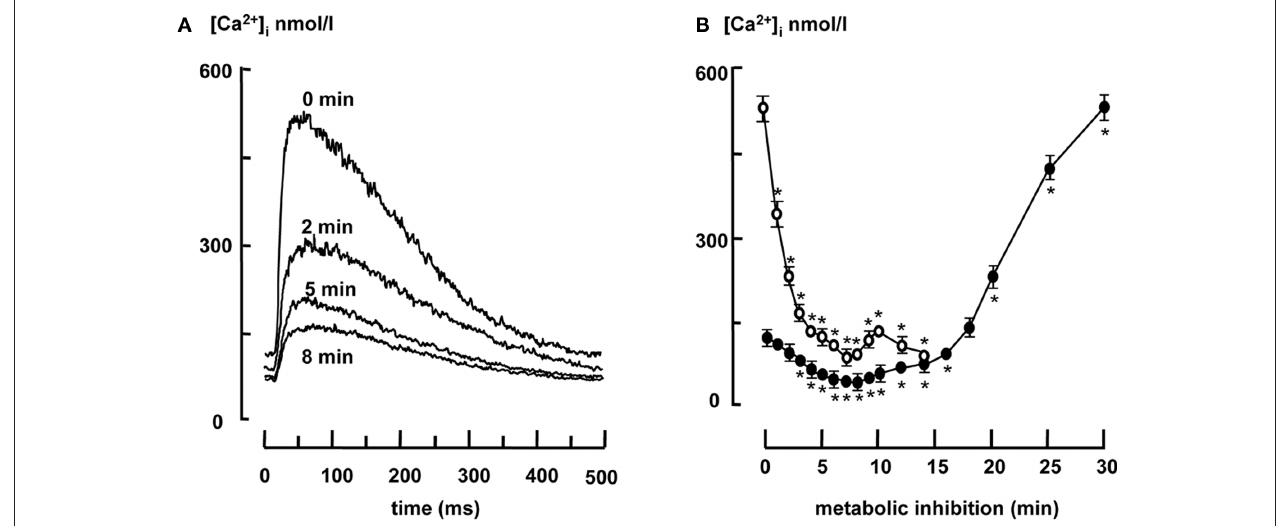
transients under aerobic conditions ( t = 0) and after 2, 5, and 8 min of metabolic inhibition. (B) Systolic (open i